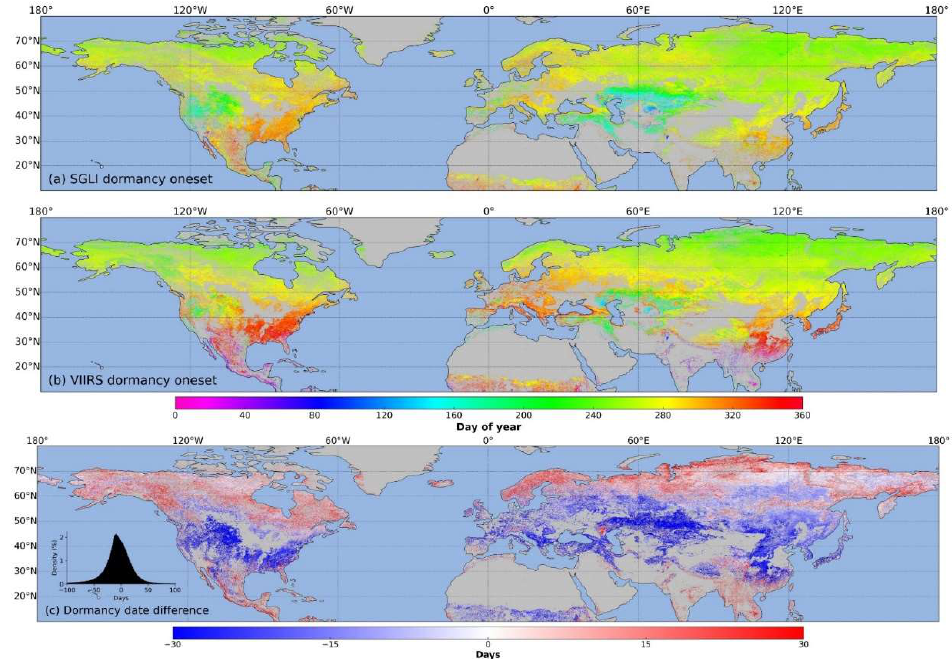
Figure 6. Spatial distribution of dormancy dates retrieved from SGLI ( a ) and VIIRS ( b ) and relative difference ( c ) in the northern hemisphere in 2018. Positive (negative) differences mean SGLI dates are later (earlier) than VIIRS dates.